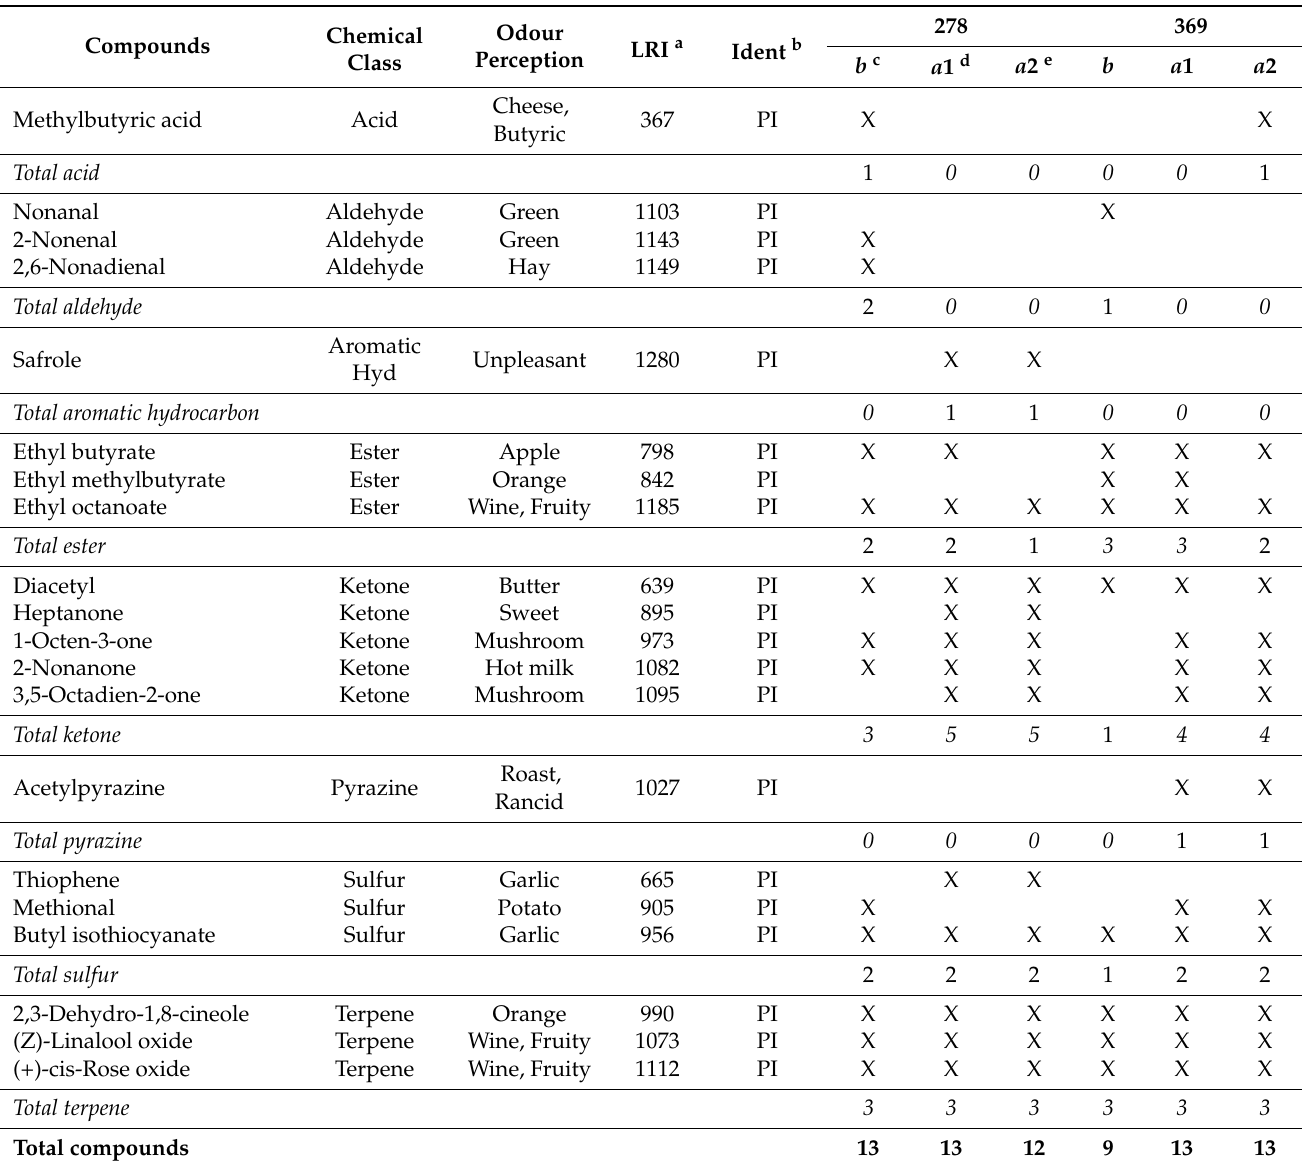
Table 4. Odour Active Compounds of artisanal pecorino-style hard cheese samples at the 0.0-kGy and 5.0-kGy radiation